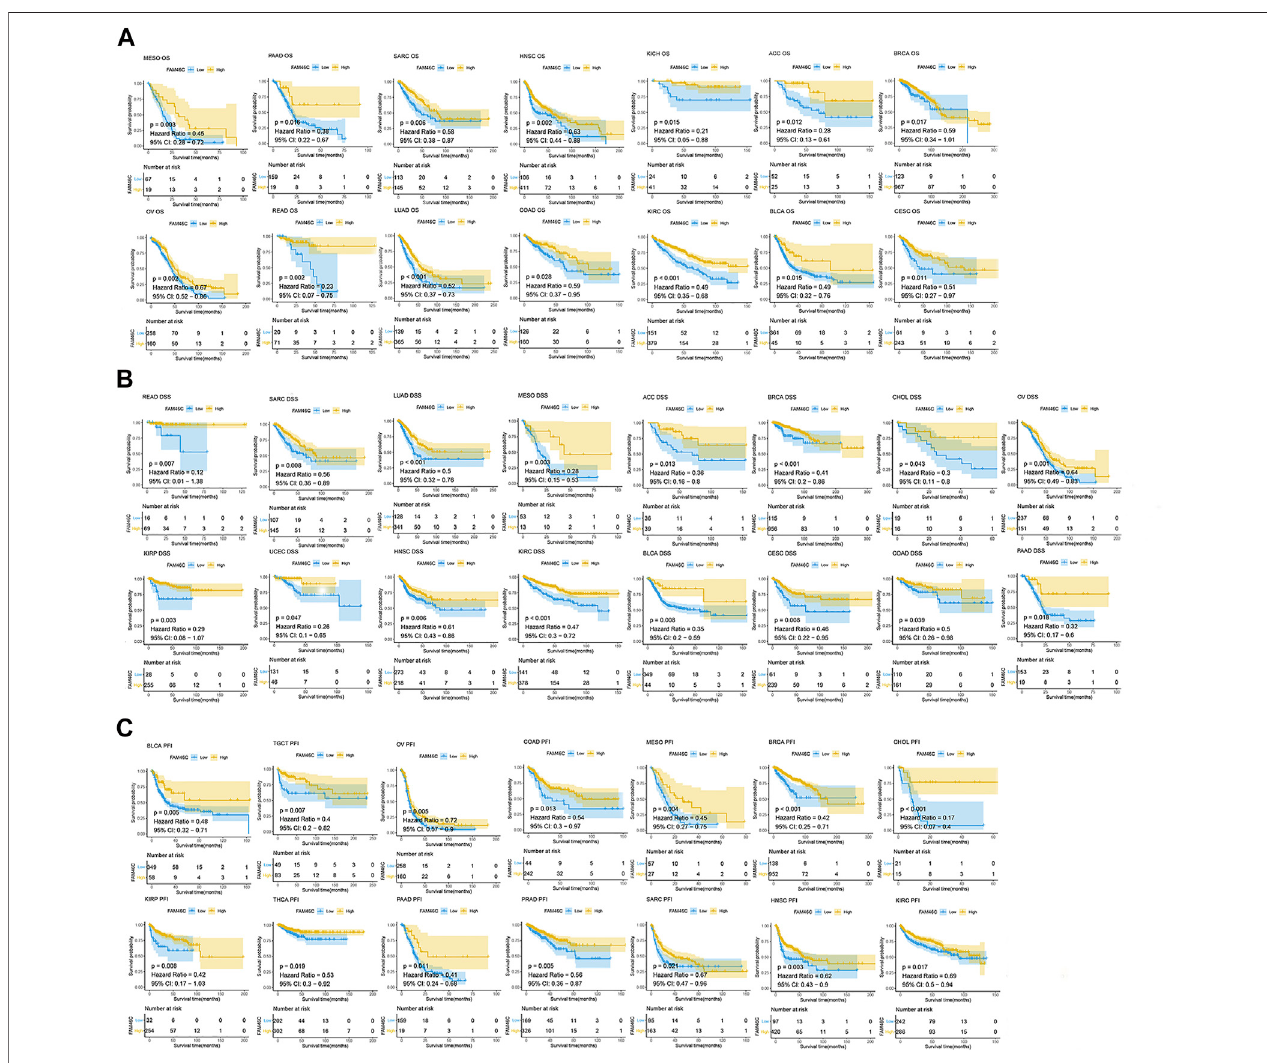
FIGURE 8 | Prognostic analysis of FAM46C using Kaplan – Meier curves for (A) OS, (B) DSS and (C) PFI in different tumours.